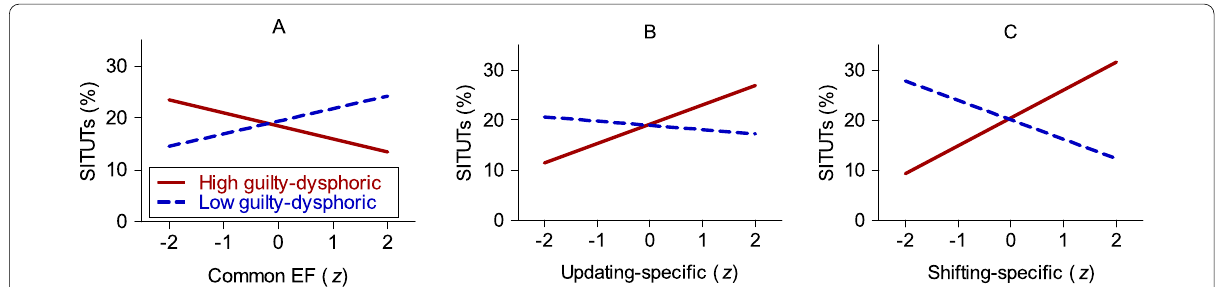
Fig. 4 The percentage of stimulus‑independent and task‑unrelated thoughts (SITUTs) as a function of guilty‑dysphoric style ( common executive functioning (EF), B updating‑specific, and C shifting‑specific abilities ( N